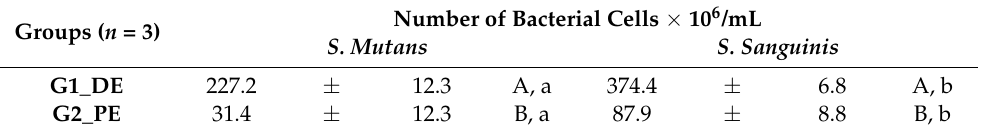
deciduous and permanent enamel obtained by XTT cell viability assay.